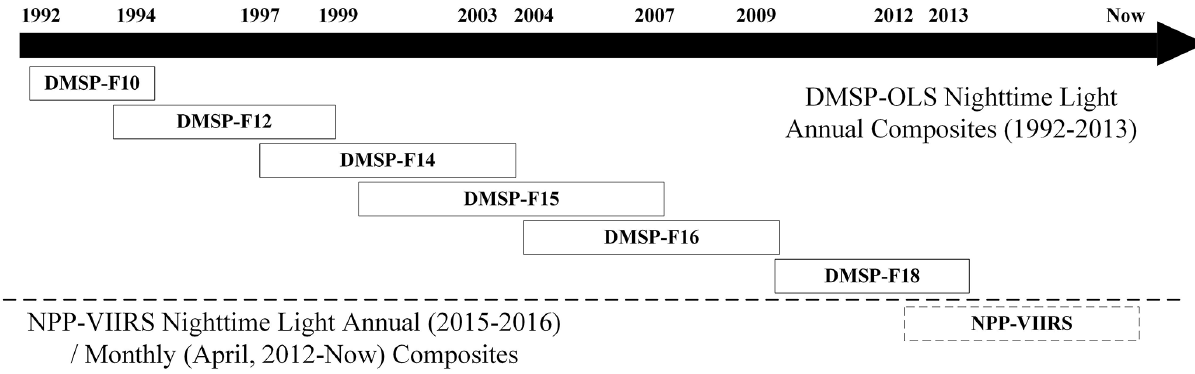
Figure 1. NTL data from DMSP-OLS and